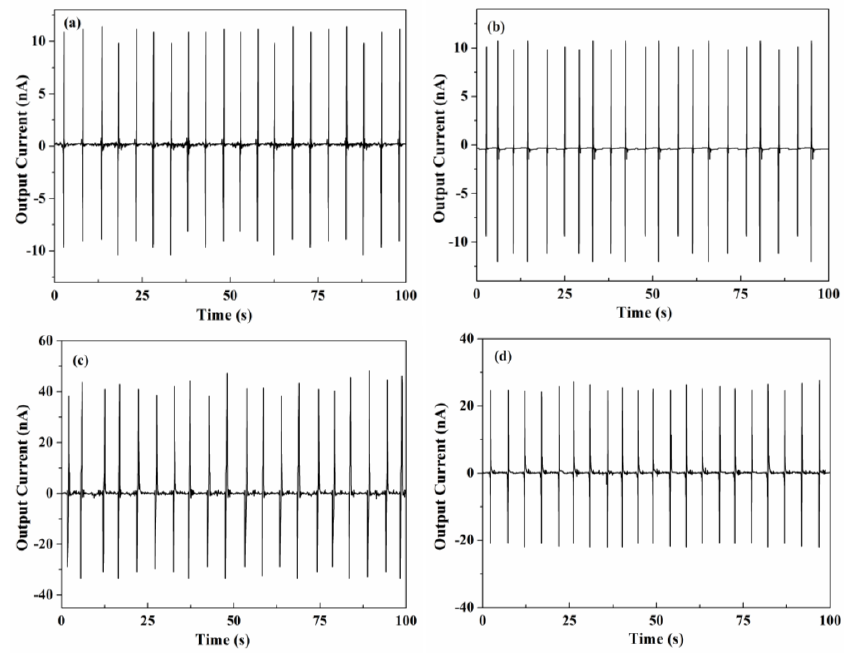
Figure 5. Current generation under a periodic mechanical tapping. ( a ) Pure PVDF; ( b ) 10 wt % PMN-PT; ( c ) 20 wt % PMN-PT; and ( d ) 25% PMN-PT.